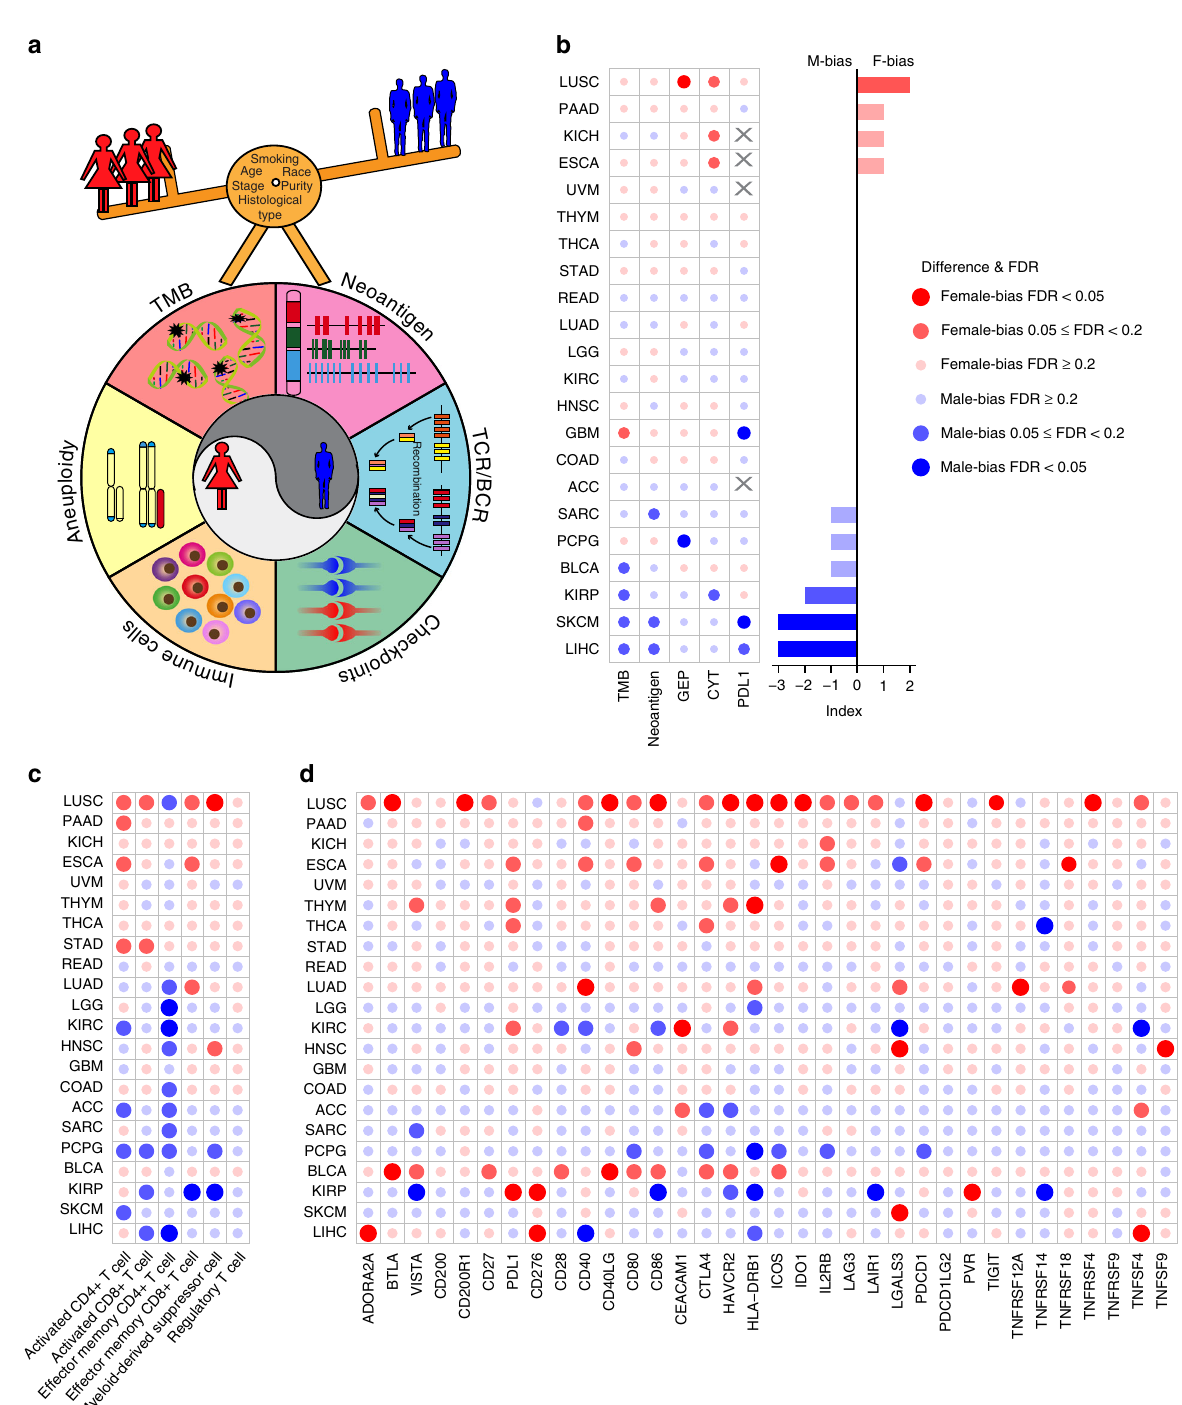
Fig. 3 Differences in immune features between male and female patients from TCGA. a Overview of the propensity score algorithm used to balance confounding effects, including age, race, tumor purity, tumor stage, subtype and smoking history, and to evaluate the sex-associated immune features, including TMB, neoantigen load, TCR/BCR, checkpoints, immune cell population and aneuploidy, across cancer types. b Differences of molecular biomarkers, including TMB, neoantigen load, GEP, CYT and PD-L1 protein expression, reported in immunotherapy data sets between male patients and female patients. Bar plots indicate the number of signi fi cant female-biased features minus the number of signi fi cant male-biased features. c Differences of relative abundance of six immune cell populations, including active CD4/CD8 T cells, effector memory CD4/CD8 T cells, myeloid-derived suppressor cell and regulatory T cells. d Differences of mRNA expression level of 34 immune checkpoints, including LAG3, CTLA-4, PDCD1 and CD274. X axis denotes immune features. Y axis of b – d denotes 22 cancer types analyzed by the propensity score algorithm and ordered by the number of signi fi cant female- biased features minus the number of signi fi cant male-biased features in b . Statistical analysis was performed using a propensity score algorithm to identify immune-associated features (see Supplementary methods). p -value was calculated by linear regression model and adjusted by Benjamini and Hochberg correction. FDR is labeled as red dots (female-bias) and blue dots (male-bias) in b – d . Sample size for each data set was listed in Supplementary Table